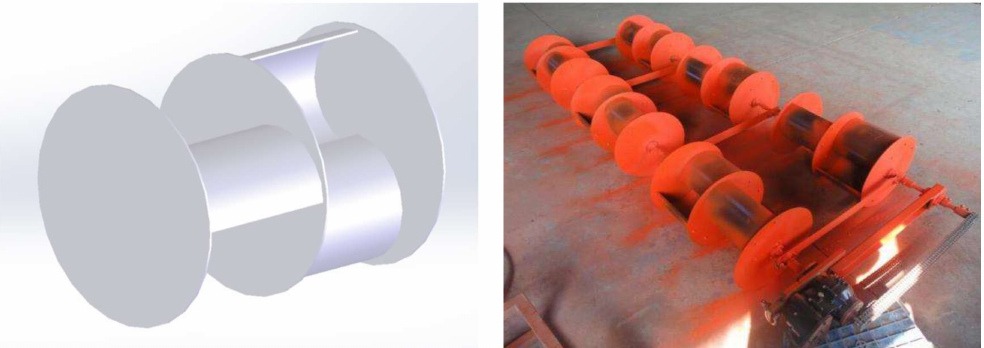
Figure 8. The physical model of the Savonius